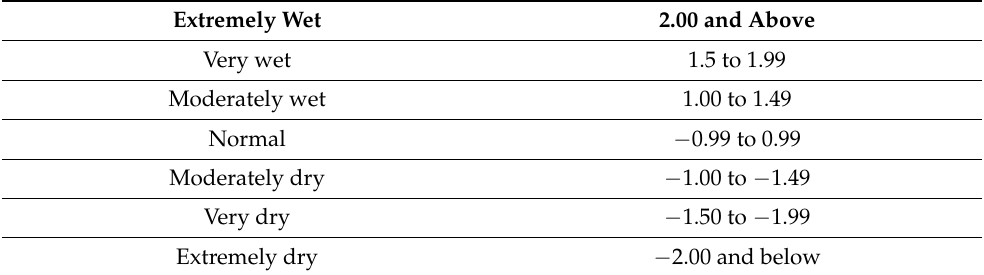
Table 2. SPI thresholds for wet and dry periods. Adopted from